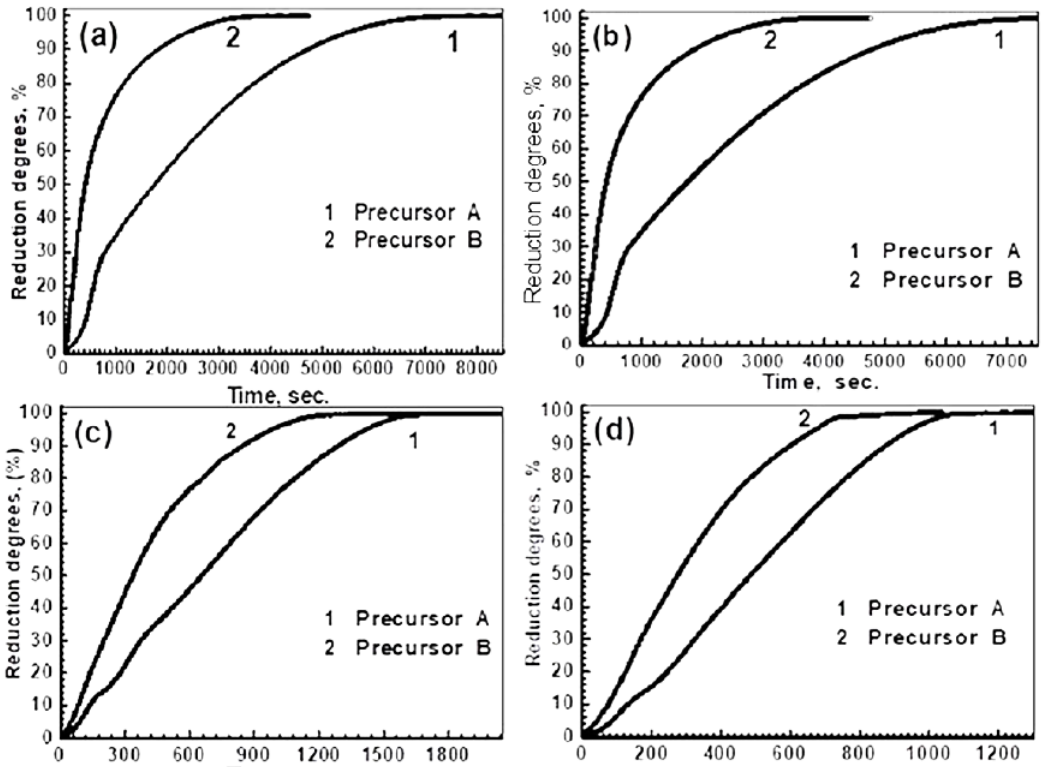
Figure 7. Influence of precursor composition on the isothermal reduction behavior with H 2 at ( a ) 650 °C; ( b ) 700 °C; ( c ) 750 °C; and ( d ) 800 °C.